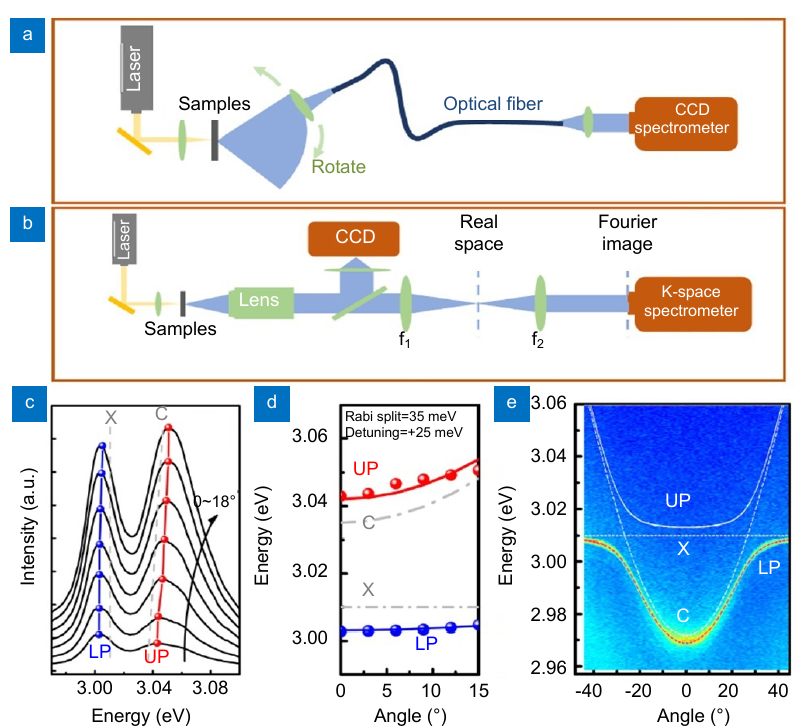
Fig. 2 | ( a ) Schematic of angle-resolved micro-PL setup. ( b ) Schematic of angle-resolved PL Fourier image setup. ( c ) The angle resolved micro-PL of positive detuning sample. ( d ) LPB and UPB dispersion curves fitted by coupled oscillator model. ( e ) The angle resolved micro-PL Fourier image of negative detuning